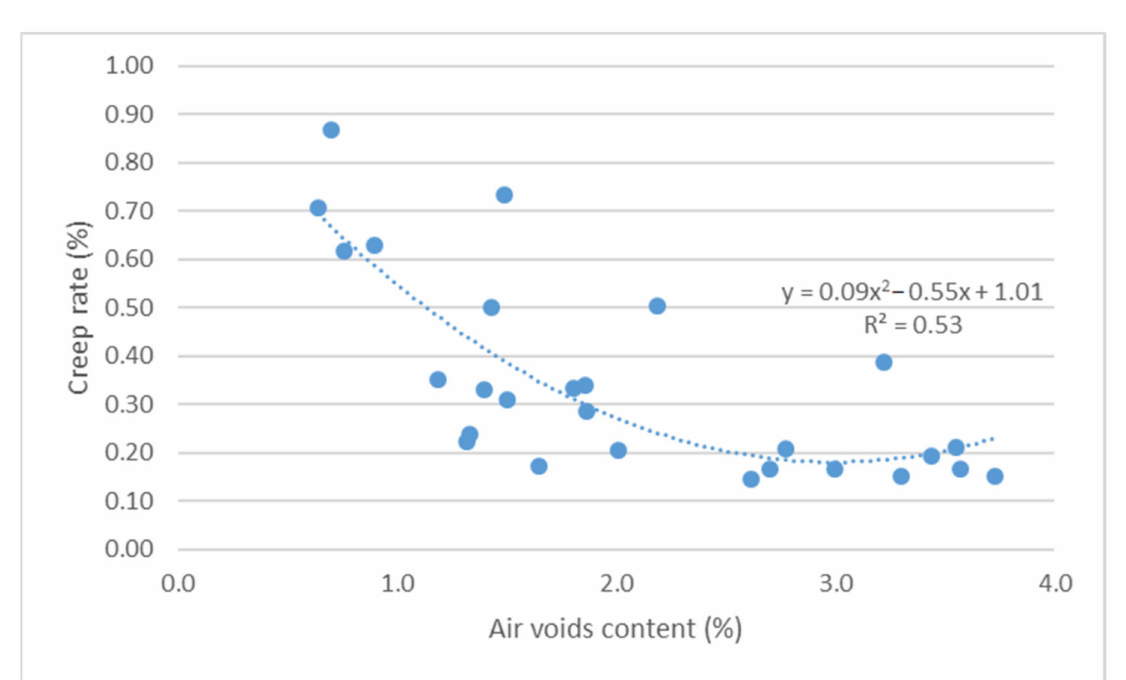
Figure 9. Cumulative axial strain vs. air void content.